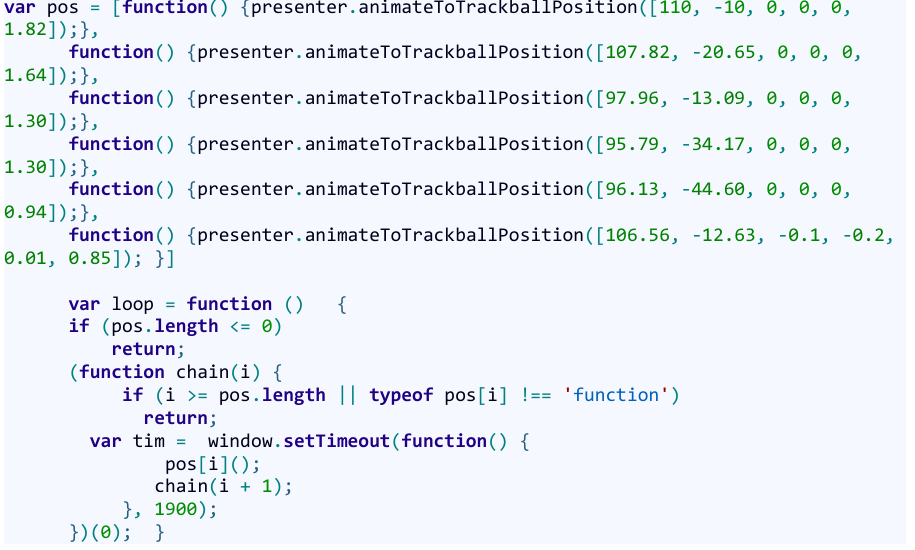
} Figure 12. The JavaScript setTimeout method iterates “pos”, the array that contains the anonymous functions with parameter a 3DHOP’s exposed method, within a callback function.